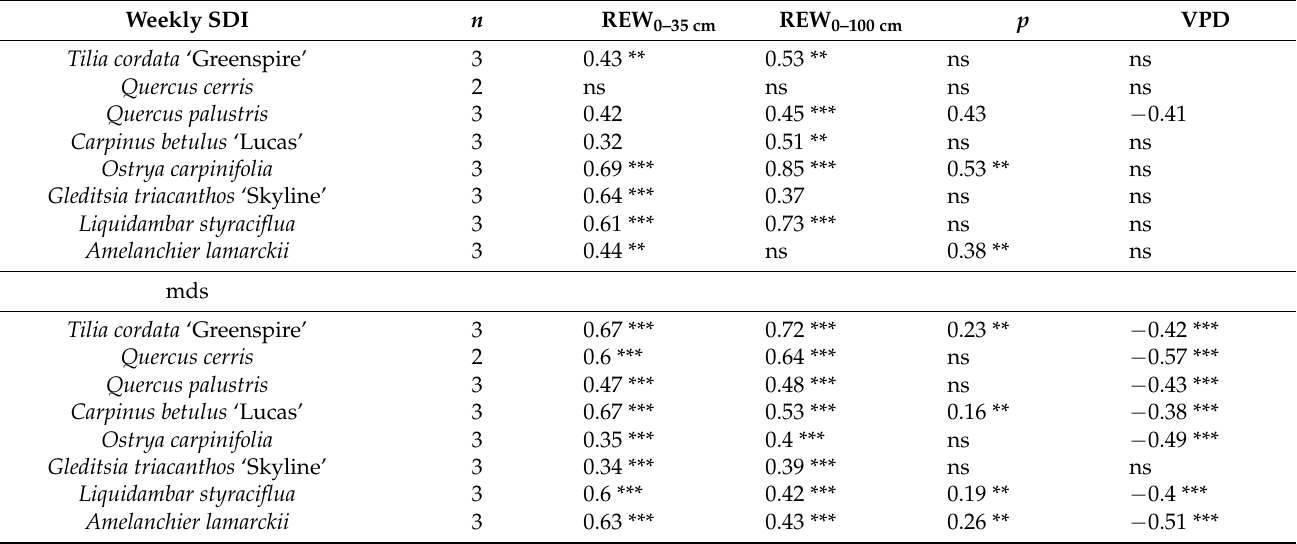
Table 4. Spearman correlation coefficients ® for the correlation of the relative stem diameter increment as weekly means (SDI; n = 20 data points per individual tree) and maximum daily shrinkage (mds; n = 173 data points per individual tree) of the stem diameter with the hydrological and climatological variables REW (relative extractable water), p (precipitation), and VPD (vapor pressure deficit) in eight species. Investigated period is defined according to the species-specific growing season length (Table